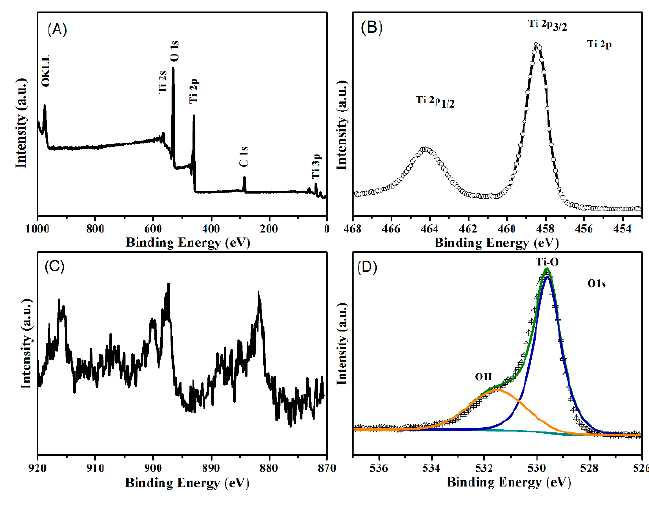
Figure 4. X-ray photoelectron spectroscopy (XPS) survey of Ce-doped LTO ( A ), Ti 2p ( B ), Ce 3d ( C ) and O 1s ( D ).